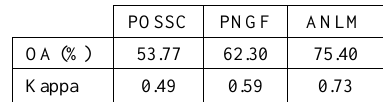
Table 3. Overall Accuracy and Kappa coefficient values based on different PolSAR de-speckling methods.